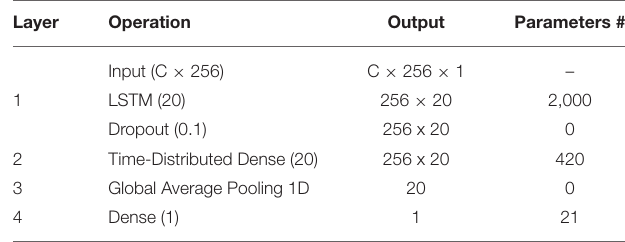
TABLE 1 | Architecture of the proposed CNN. TABLE 2 | Architecture of the proposed